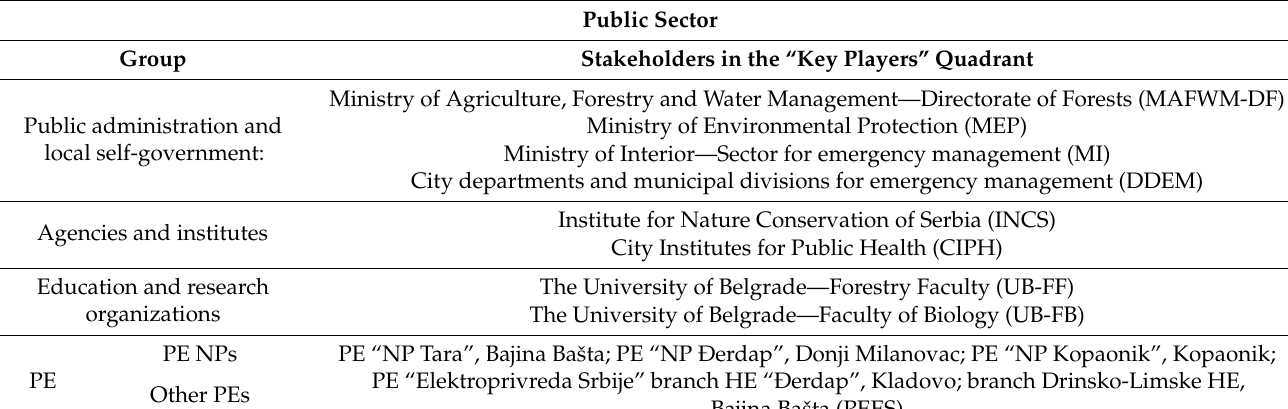
Table 3. Stakeholders overview in the “key players”